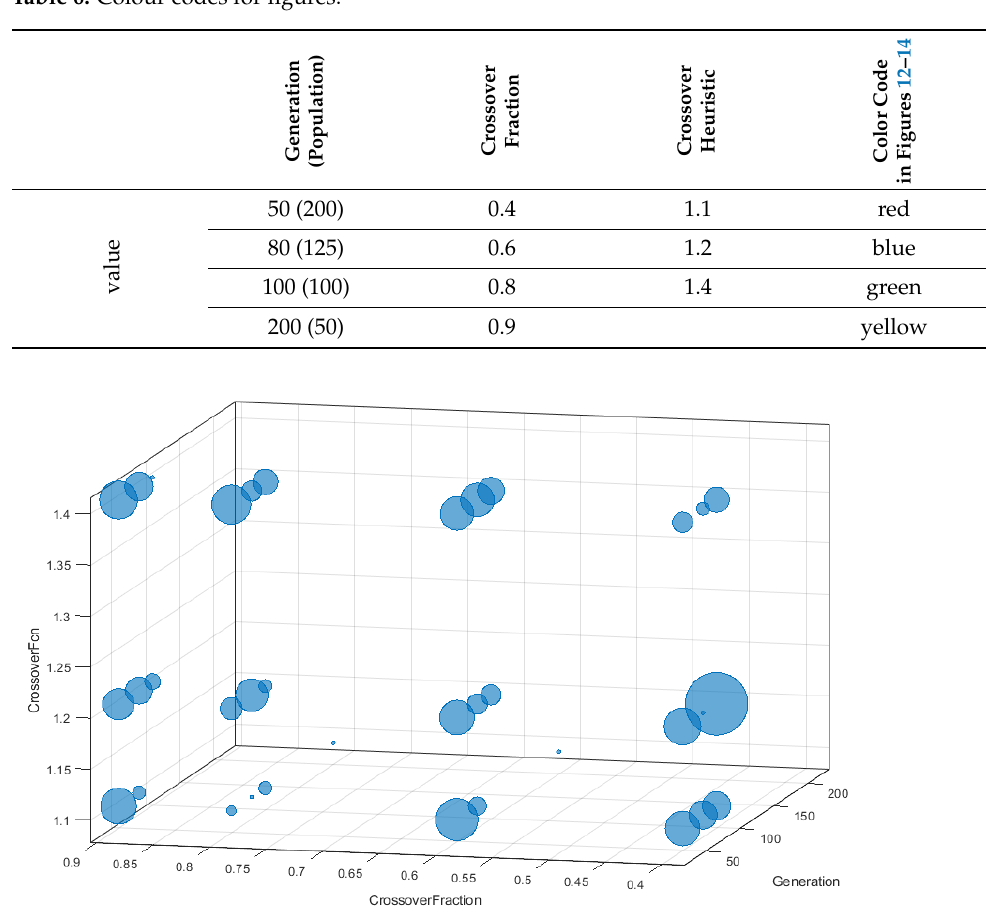
Figure 11. Number of correct solutions, depending on algorithm